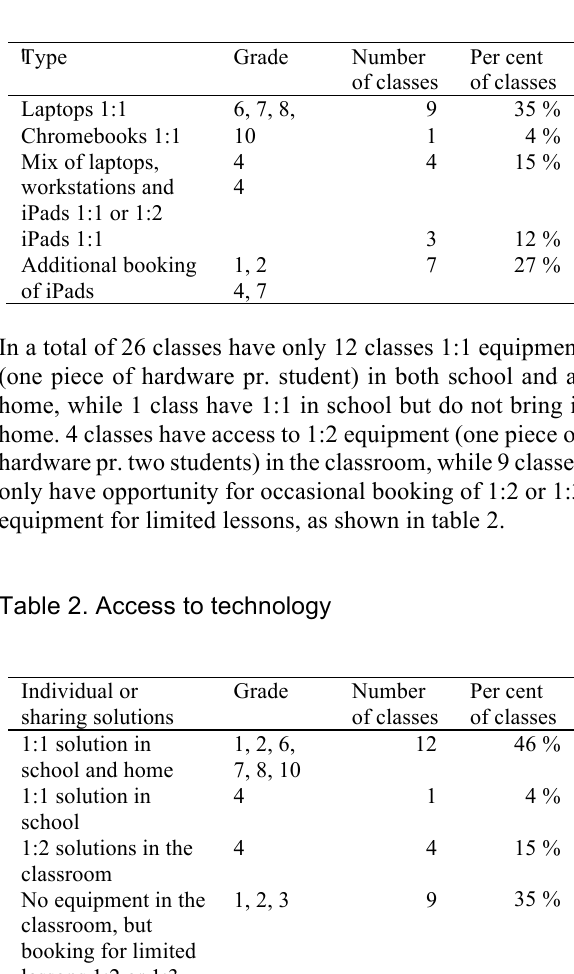
Table 1. Type of individual or shared technology Table 3. Used